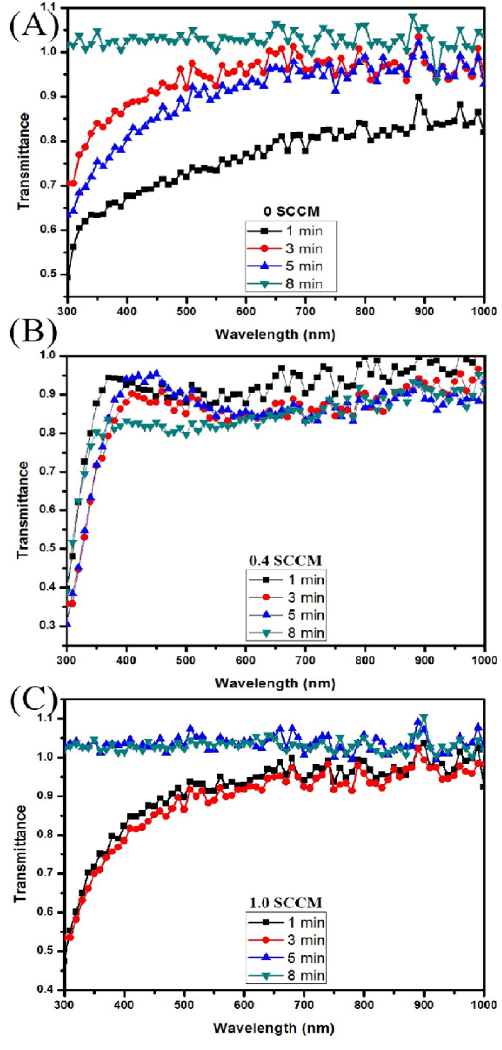
Figure 4. Optical transmission spectrum for the RF sputter deposited ITO films at different oxygen compositions and etched for min ( A ) 0 sccm, ( B ) 0.4 sccm, and ( C ) 1.0 sccm